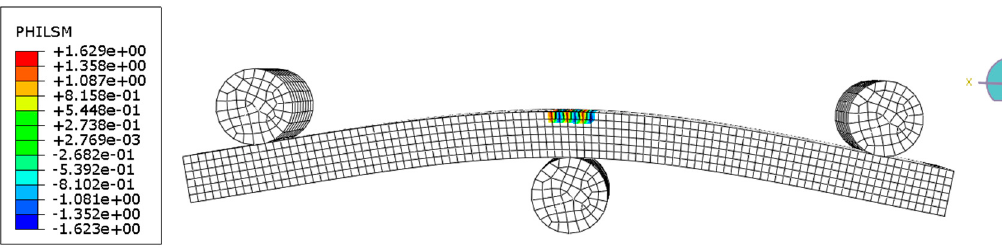
Figure 8. Singled distance function (PHILSM) for T2 model.